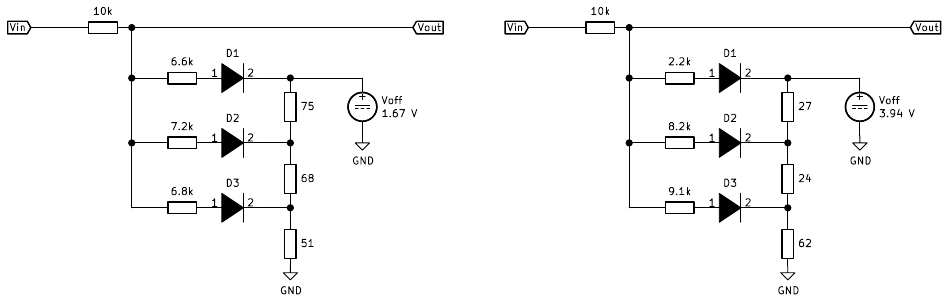
Figure 14. Examples of hand-designed piece-wise linear computational circuits: ( Left ) square root and ( Right ) natural logarithm